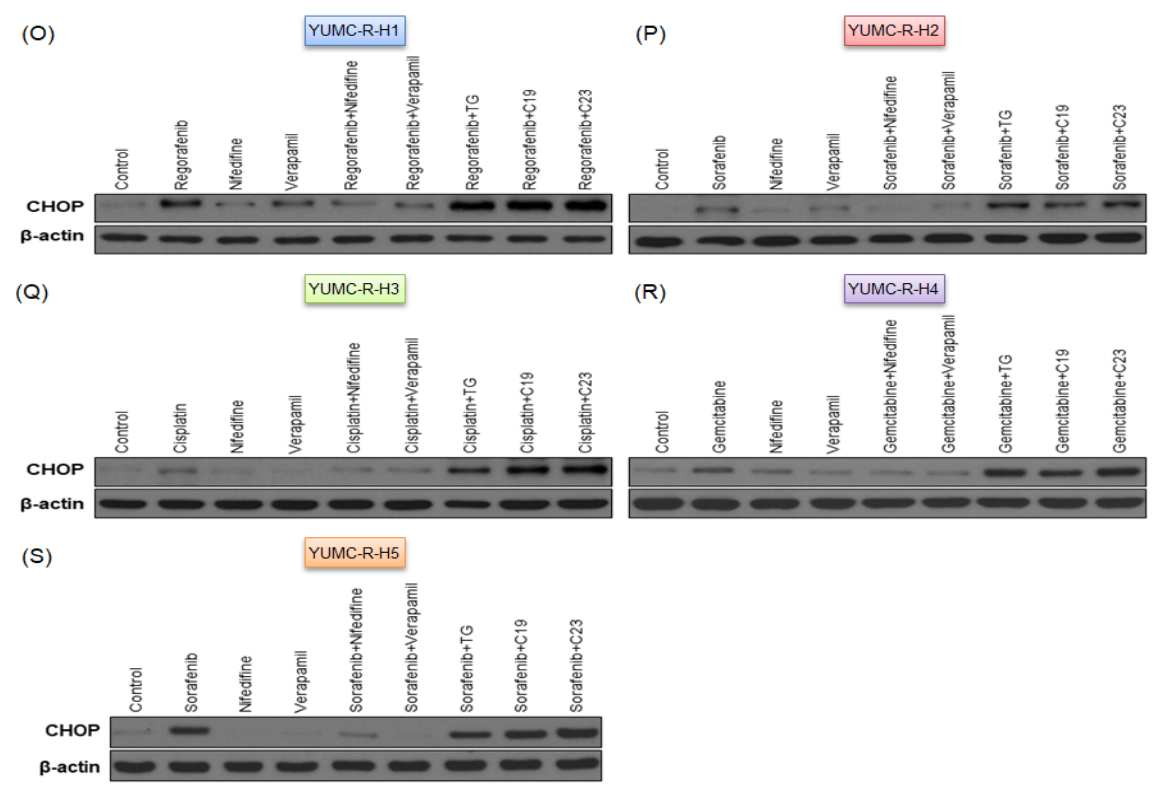
Figure 5. Analysis of the relationship between endoplasmic reticulum (ER) stress and apoptosis by immunoblotting and DNA quantitation. Immunoblot ( A – I ) and flow cytometry ( J – N ) analyses of patient ‐ derived anti ‐ cancer drug ‐ sensitive and ‐ resistant HCC cells. Immunoblot analysis of CHOP and SERCA in YUMC ‐ S ‐ H1 ( A – D ) and YUMC ‐ R ‐ H1, ‐ H2, ‐ H3, ‐ H4, and ‐ H5 ( E – I ). ( J – N ) Cells were treated with the indicated anti ‐ cancer drug combined with a SERCA inhibitor or with each agent alone, harvested, and stained with propidium iodide before analysis using flow cytometry. ( O – S ) Immunoblot analysis of CHOP in drug ‐ resistant HCC cells treated with a combination of an anti ‐ cancer drug, calcium channel blockers, and a SERCA inhibitor or with each agent alone.